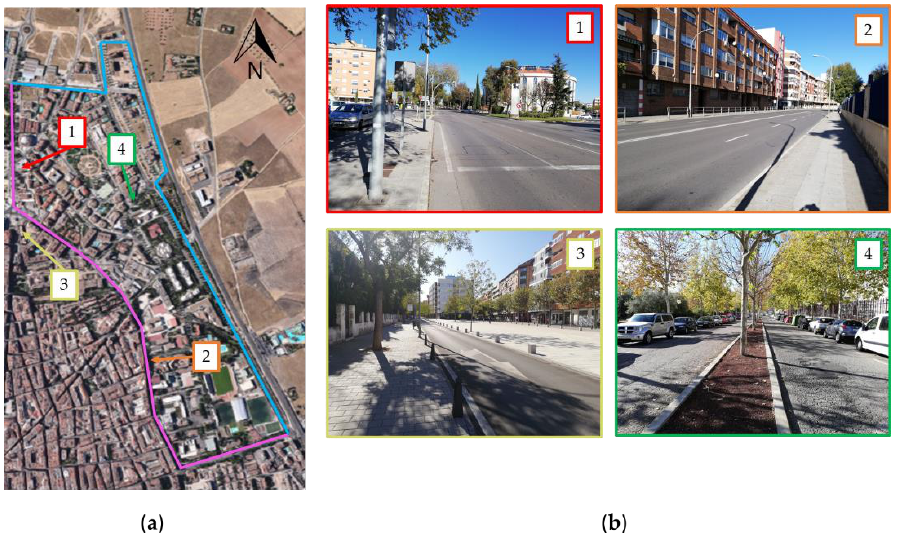
Figure 11. ( a ) Representation of the corridor, in violet, where the greatest flows and difficulties in installing a sensor take place; ( b ) Images of several links on the network.